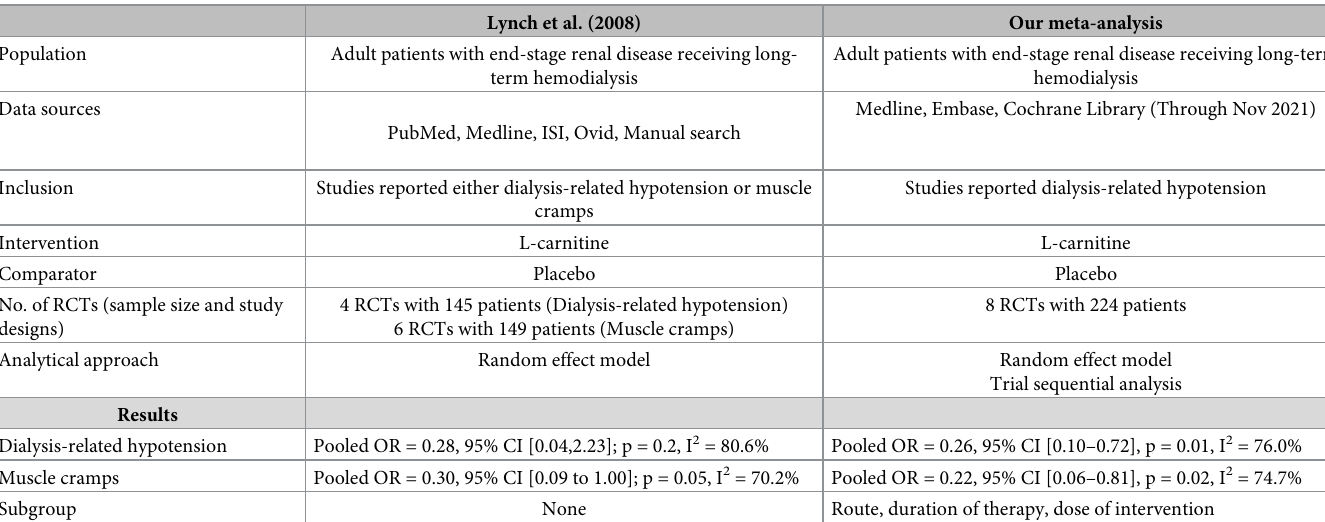
Table 4. Comparison between previous meta-analysis and the present